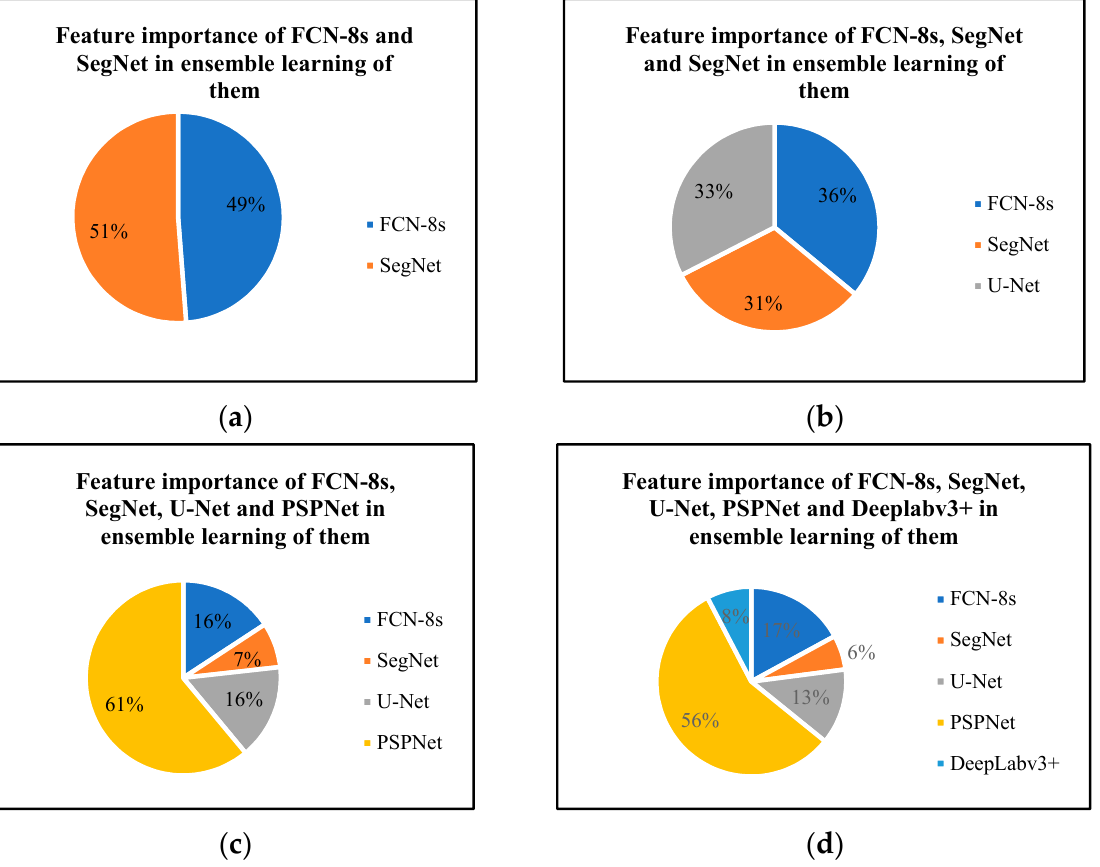
Figure 9. Feature importance of semantic segmentation network base models in softmax regression- based ensemble learnings: ( a ) ensemble learning of FCN-8s and SegNet, ( b ) ensemble learning of FCN-8s, SegNet, and U-Net, ( c ) ensemble learning of FCN-8s, SegNet, U-Net, and PSPNet and ( d ) ensemble learning of FCN-8s, SegNet, U-Net, PSPNet, and DeepLabv3+.